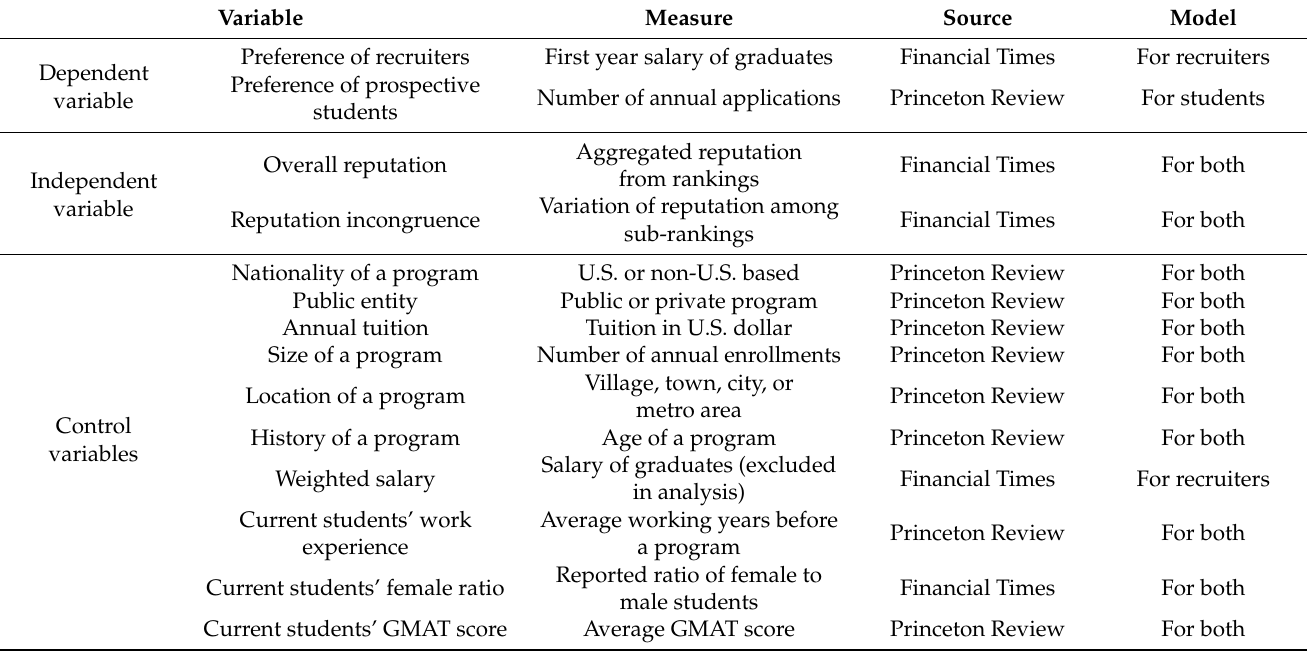
Table 1. Summary of variables included in the GEE